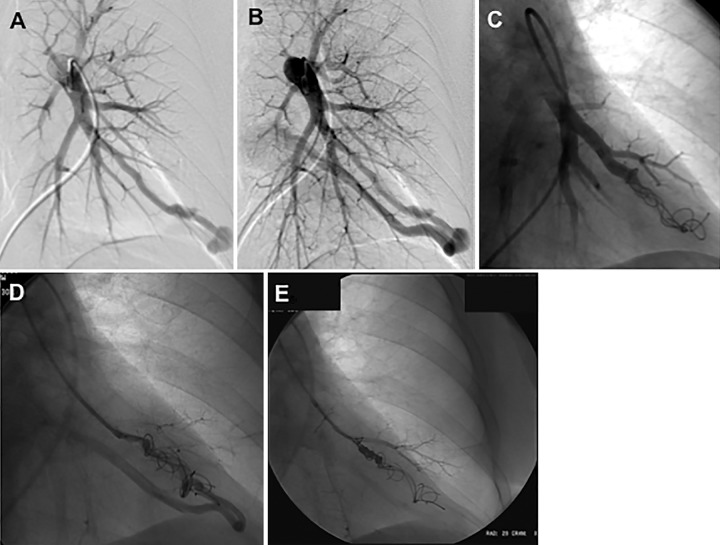
Images in a 52-year-old woman with hereditary hemorrhagic telangiectasia
demonstrate on left pulmonary artery angiogram an arteriovenous
malformation (AVM) at, A, B, the left
base. C, Selective angiogram after embolization of the
AVM by using coils. D, E, Angiograms
show embolization for persistence treated with repeat embolization
performed 2 years after initial embolization.